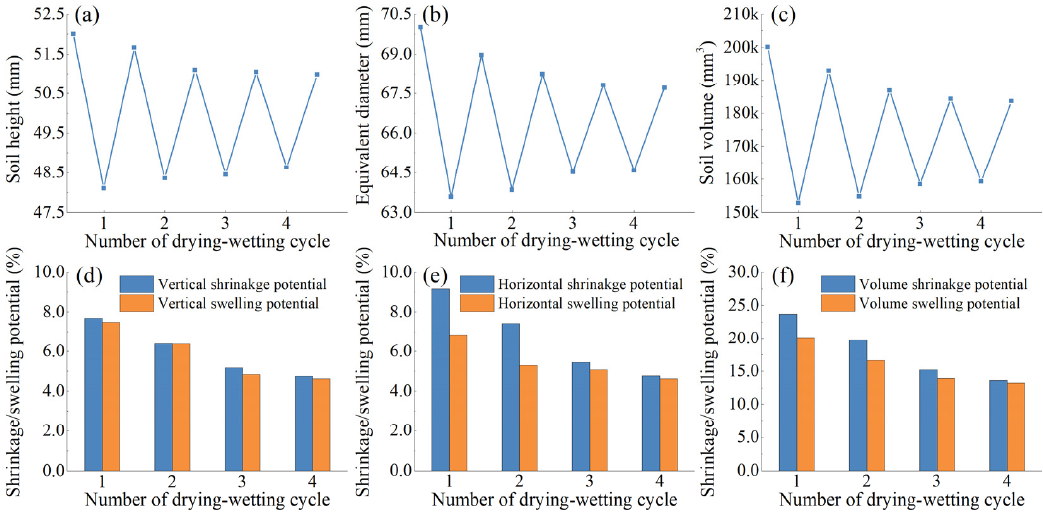
Figure 2. Evolution of soil size and shrinkage–swelling potential during four drying–wetting cycles. ( a ) Soil height; ( b ) Soil equivalent diameter; ( c ) Soil volume; ( d ) Vertical shrinkage/swelling potential; ( e ) Horizontal shrinkage/swelling potential; ( f ) Volume shrinkage/swelling potential.